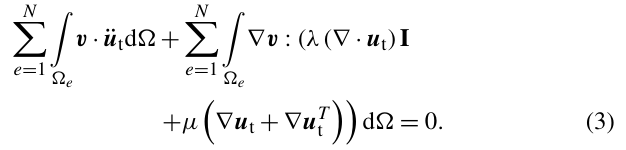
Figure 1. Schematic of a teleseismic plane wave entering a local two-layered crust–upper-mantle model. The study area is delineated by the blue lines. The origin of the Cartesian system is located on the surface at corner A of the model. The positive x and y directions point to the east and south, respectively, and the positive z direc- tion points downward. The inverted red triangle located at (60km, 60km, 0km) represents a seismic station. The plane in the lower left of the figure denotes the wave front of the incident teleseismic plane wave. The purple arrows indicates the normal vector of the plane wave. The incident angle is θ , which is the angle between the normal vector and – z . The azimuth angle is ϕ , which is the angle between the projection of the normal vector into the x – y plane and – y . The azimuth angle is not explicitly shown in this